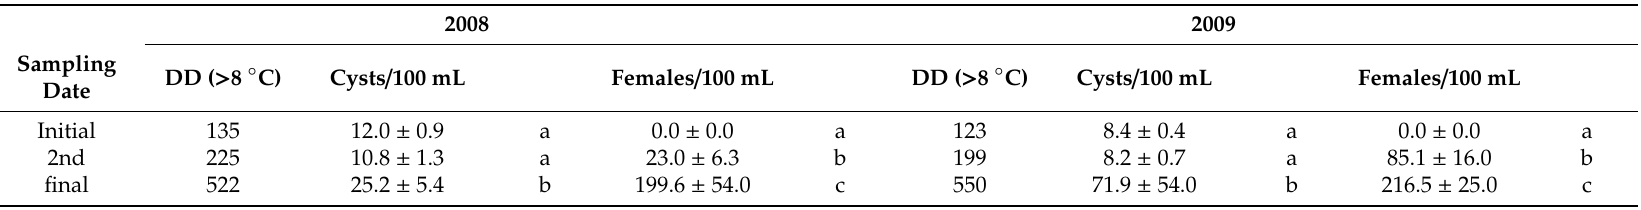
Table 1. Abundance of beet cyst nematode (BCN) females and cysts in soil from pots with oilseed rape (OSR) plants at di ff erent sampling dates after sowing; means between sampling dates only within years were tested by Fischer LSD Test ( p < 0.05) using Log( x + 1) transformed data, di ff erent letters (a–c) indicate significant di ff erences of cyst and female numbers respectively between sampling